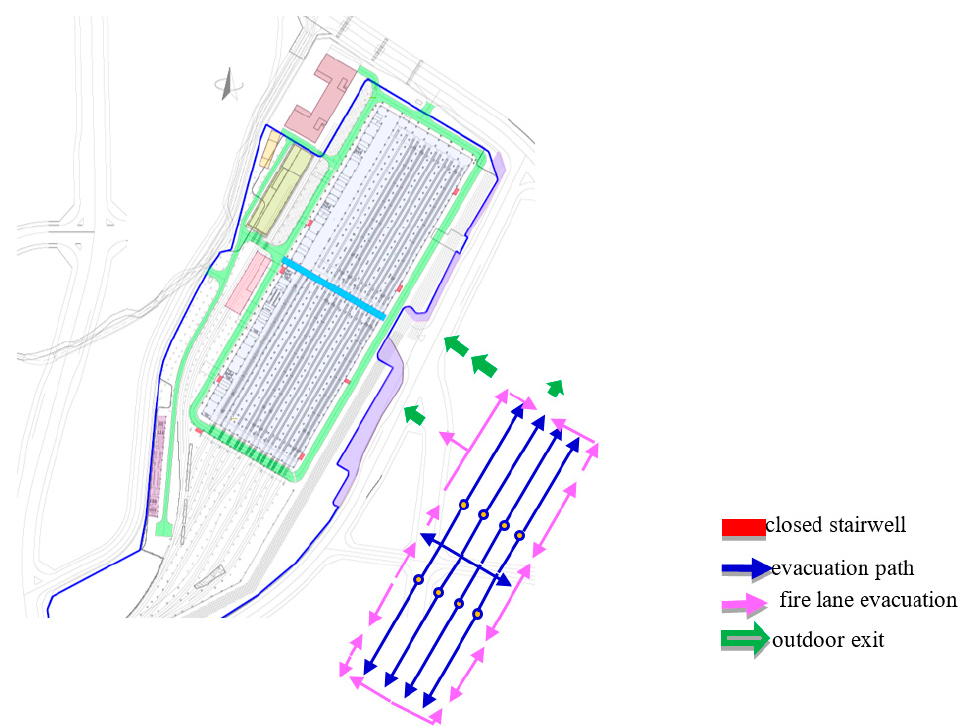
Figure 6. Schematic diagram of the evacuation path using the use library.